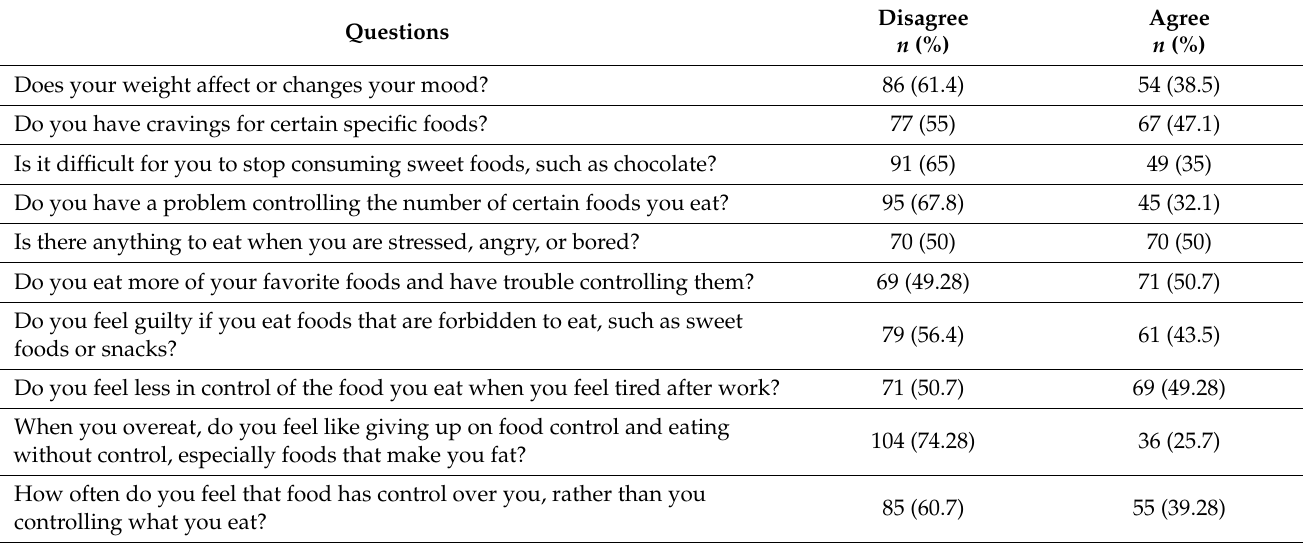
Table 8. Emotional eating questionnaire